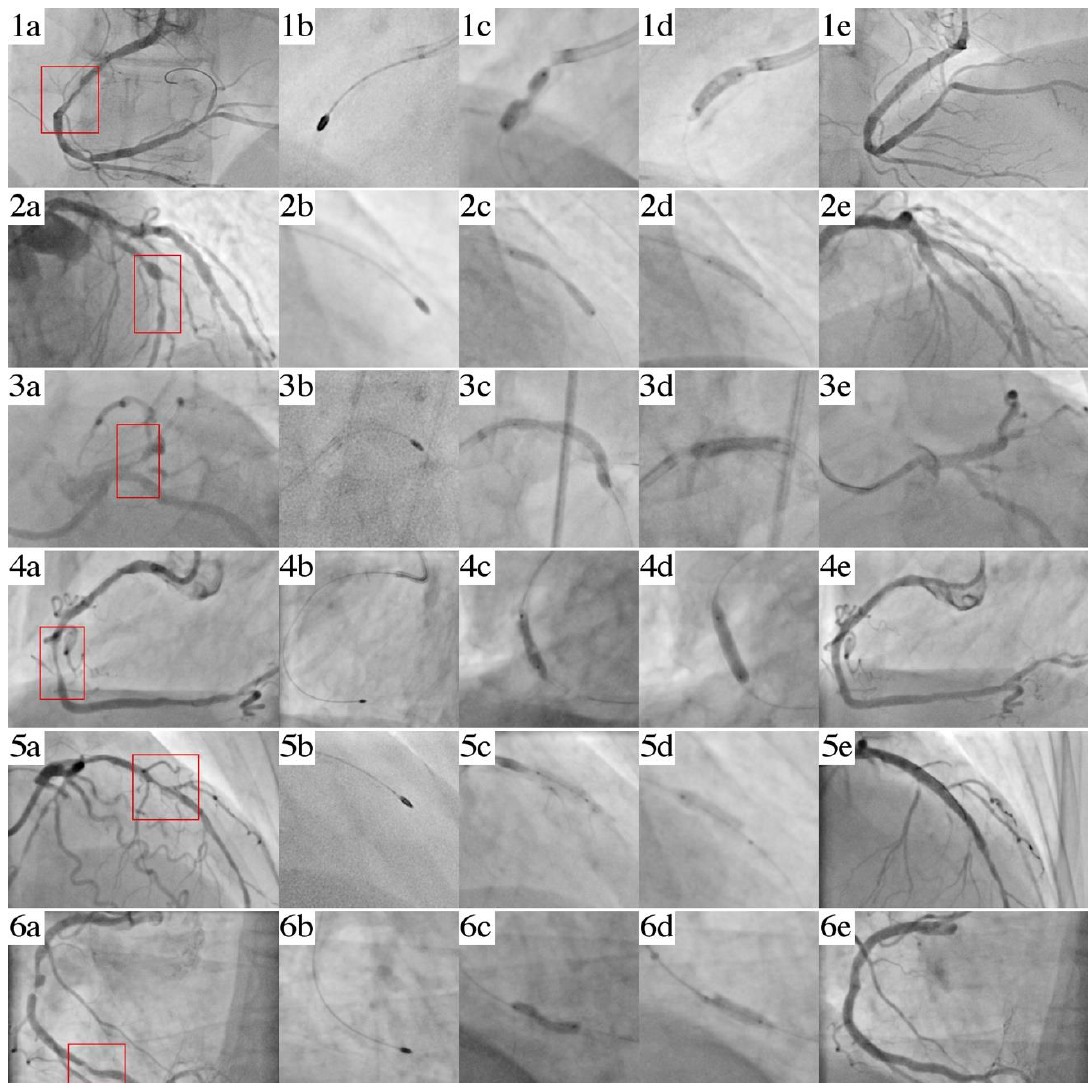
Figure 2. Series of cases: intervention images ,Case I: ( a1 ) undilatable lesion; ( b1 ) rotational atherectomy; ( c1 ) underexpan- sion of 3.5 mm × 15 mm NC balloon; ( d1 ) S-IVL balloon 3.5 mm × 12 mm; ( e1 ) final angiogram; Case II: ( a2 ) undilatable lesion; ( b2 ) rotational atherectomy; ( c2 ) underexpansion of 3.0 mm × 20 mm NC balloon; ( d2 ) S-IVL balloon 3.0 mm × 12 mm; ( e2 ) final angiogram; Case III: ( a3 ) undilatable lesion; ( b3 ) rotational atherectomy; ( c3 ) underexpansion of 3.0 mm × 20 mm NC balloon; ( d3 ) S-IVL balloon 3.5 mm × 12 mm; ( e3 ) final angiogram; Case IV: ( a4 ) undilatable lesion; ( b4 ) rotational atherectomy; ( c4 ) underexpansion of 3.0 mm × 15 mm NC balloon; ( d4 ) S-IVL balloon 3.5 mm × 12 mm; ( e4 ) final angiogram; Case V: ( a5 ) undilatable lesion; ( b5 ) rotational atherectomy; ( c5 ) perforation of 3.0 × 15mm NC balloon; ( d5 ) S- IVL balloon 3.5 mm × 12 mm; ( e5 ) final angiogram; CaseVI: ( a6 ) undilatable lesion; ( b6 ) rotational atherectomy; ( c6 ) un- derexpansion of 3.0 mm × 20 mm NC balloon; ( d6 ) S-IVL balloon 3.5 mm × 12 mm; ( e6 ) final angiogram.